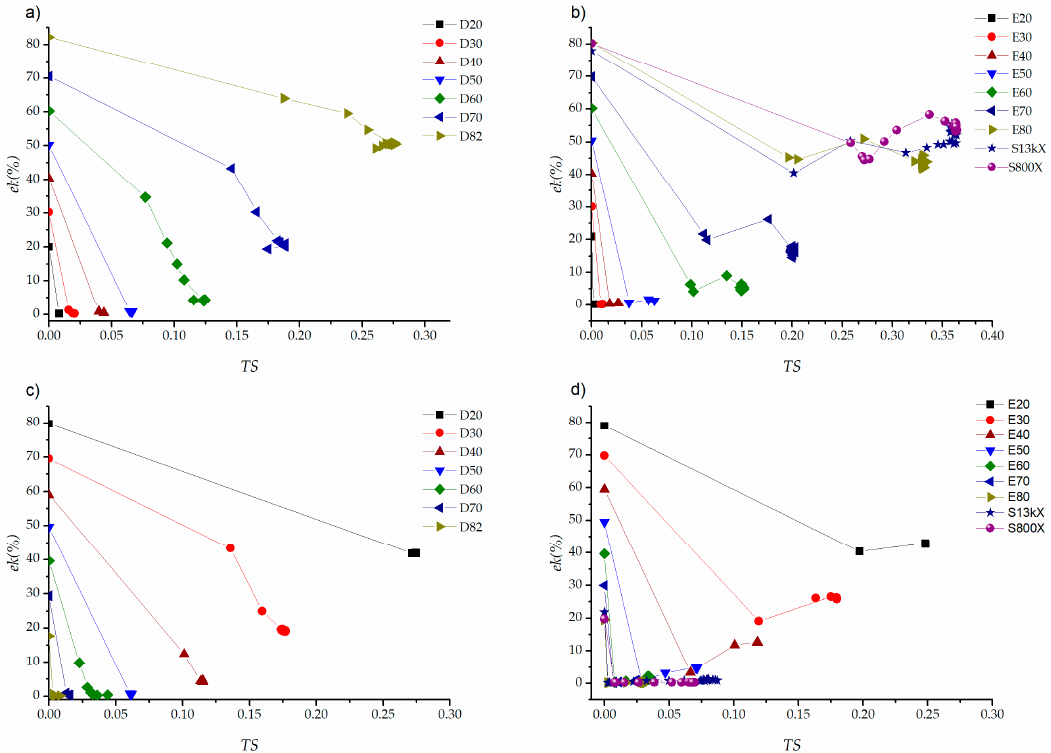
Figure 10. Average of ek (%) as a function of the topological entropy, ( a ) ek (%) for the analyzed D systems in the matrix phase; ( b ) ek (%) for systems E and S in the matrix phase; ( c ) ek (%) for the systems D in the dispersion phase and ( d ) ek (%) for systems E and S in the dispersion